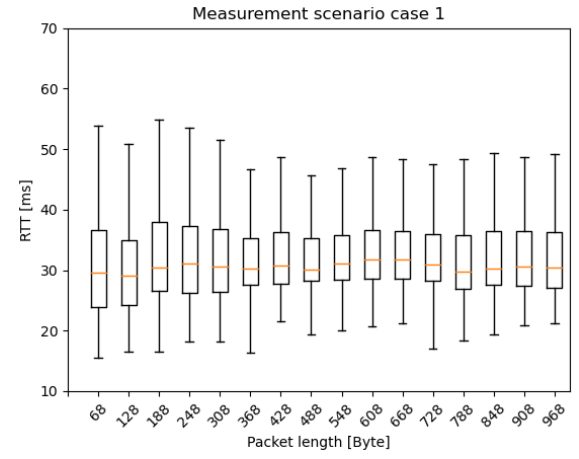
Figure 24. Latency results of the measurement scenario 1 with different packet